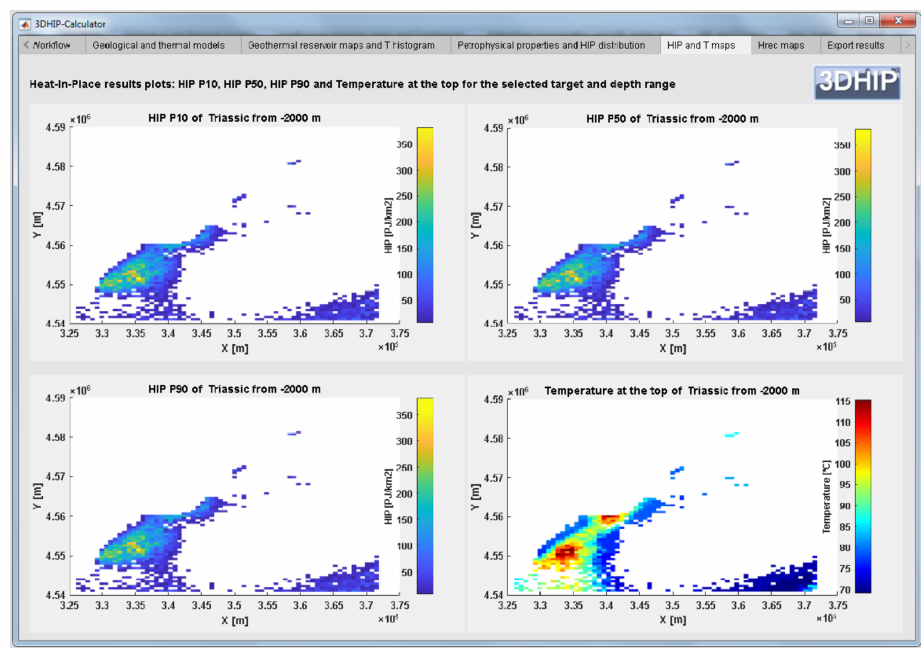
Figure 6. 2D maps of the HIP results of the P10, P50, and P90, and the temperature distribution at the top of the Triassic units below the pre-fixed depth range. For the HIP parameters, the values were calculated as an integration over the depth range and normalized by the voxel area. Units are in PJ/km 2 and ◦ C,